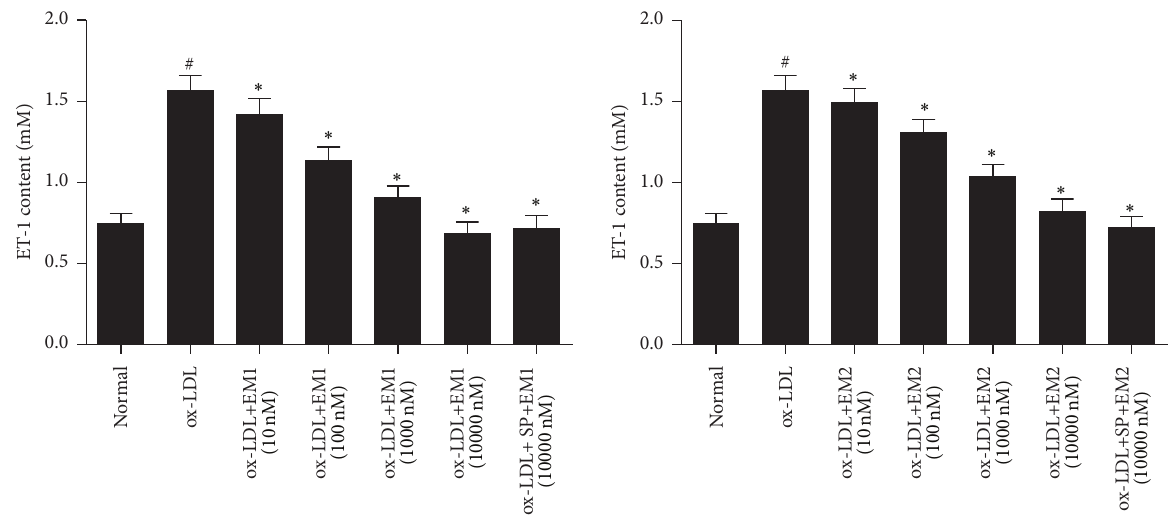
Figure 4: Inhibitory effect of EM1/EM2 on production of ET-1 in HUVECs treated by ox-LDL. All data is expressed as mean ± SD. ∗ 𝑃 < 0.05 versus control. # 𝑃 < 0.05 versus